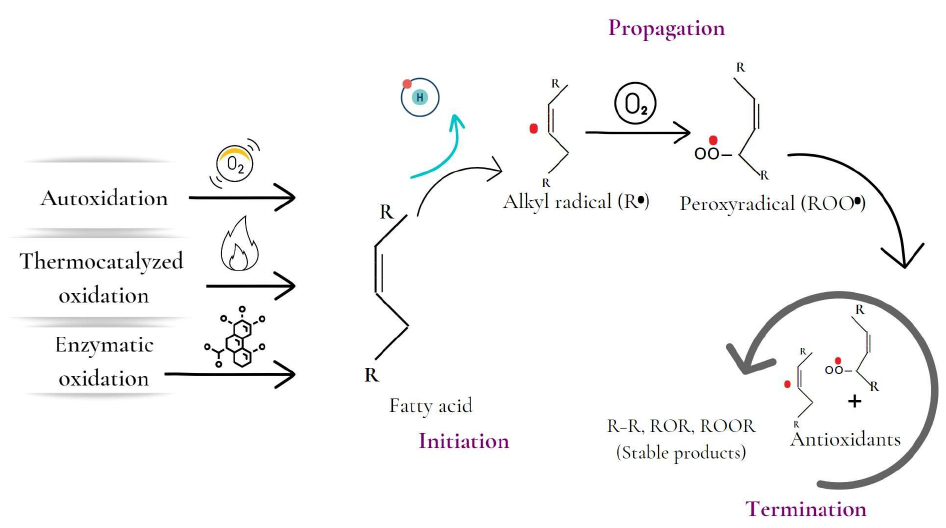
Figure 2. Stages of the lipid oxidation process initiated by autocatalyzed, thermocatalyzed, and enzymatic oxidation mechanisms.